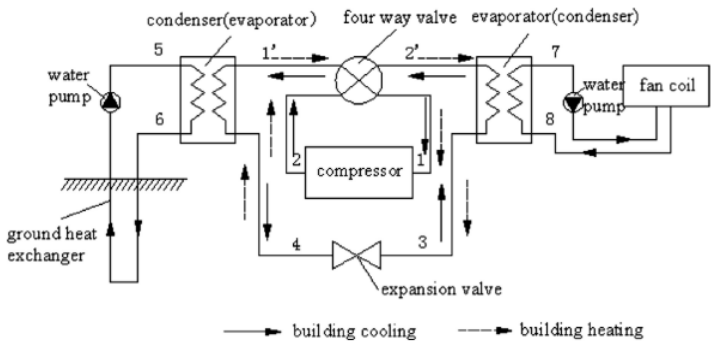
Figure 9. Layout of the ground source heat pump (GSHP) system analyzed in [32].